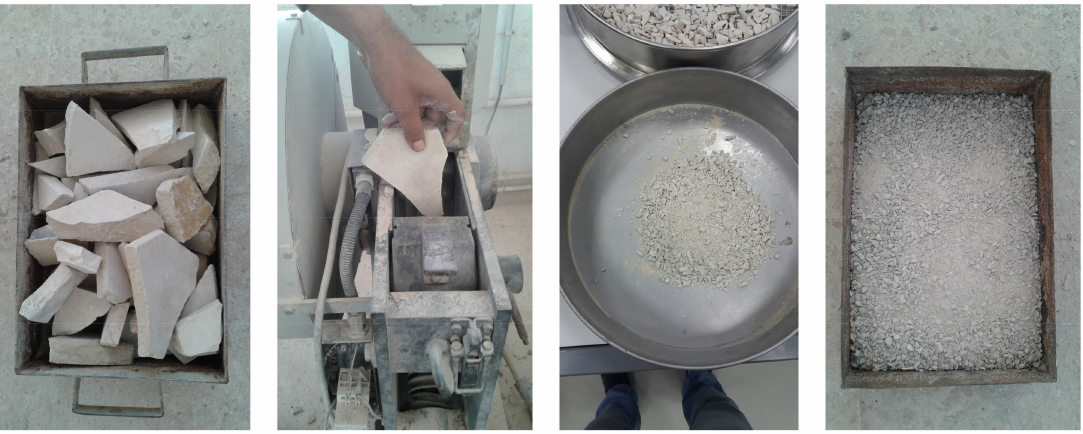
Figure 3. Preparation of Marble Wastes Sand